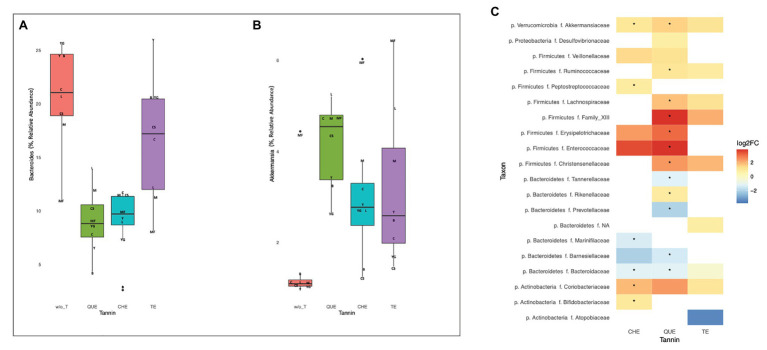
Changes in microbiota composition with tannin addition in all foods. (A) Decrease of Bacteroides (QUE: p = 0.0078, adjusted p = 0.048; CHE: p = 0.0078, adjusted p = 0.11; TE: p = 0.023, adjusted p = 0.14) and (B) increase of Akkermansia (QUE: p = 0.0078, adjusted p = 0.048; CHE: p = 0.0078, adjusted p = 0.11; TE: p = 0.0078, adjusted p = 0.079) with every tannin tested. Initials indicate the different food matrices (C, breakfast cereals; CS, breakfast cereals with sugar; B, bread; M, meat; MF, meat with 30% fat; L, milk; Y, low fat yogurt; and YG, full-fat Greek yogurt). (C) Fold-changes in the relative abundance of bacterial families with each tannin. All changes significant at nominal level by Wilcoxon signed-rank tests are shown (p < 0.05). *Indicates statistically significant differences (p < 0.05) after correction for multiple testing.